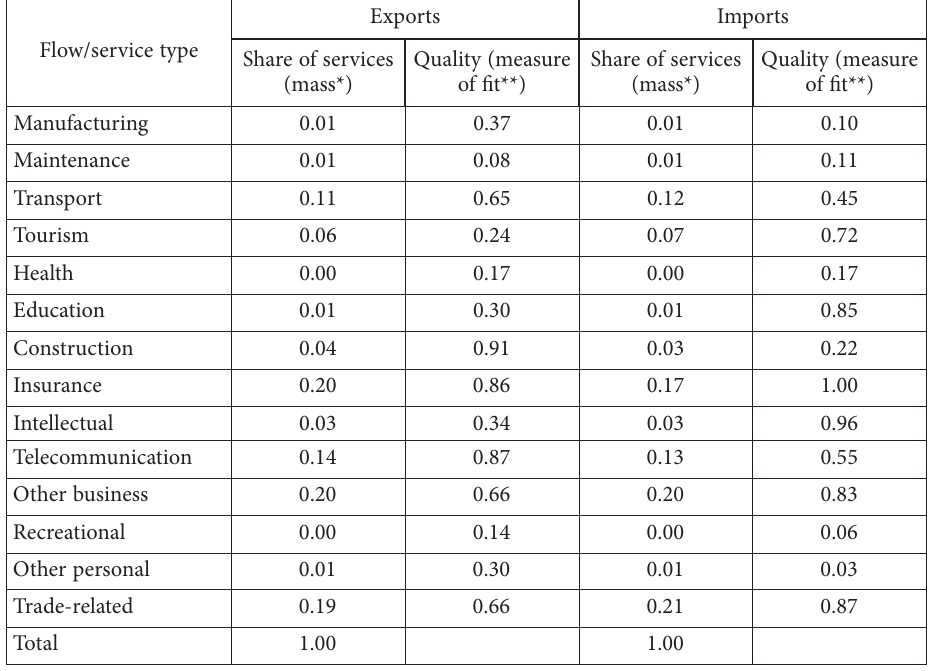
Table 1. Service exports and imports by service type: correspondence analysis results